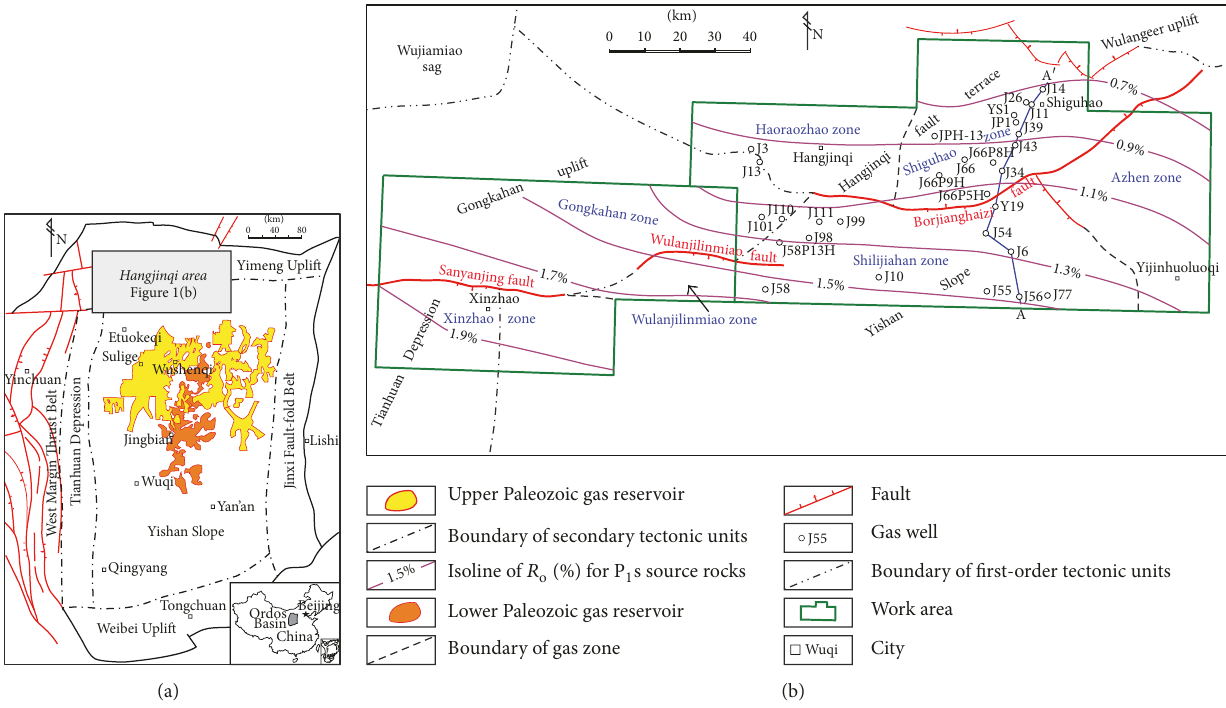
Figure 1: (a) Location map of the Hangjinqi area and the distribution of tectonic units in the Ordos Basin; (b) distribution map of the tectonic units, gas zones, and gas wells in the Hangjinqi area. The isolines of 𝑅 o (%) are modified after Ji et al.